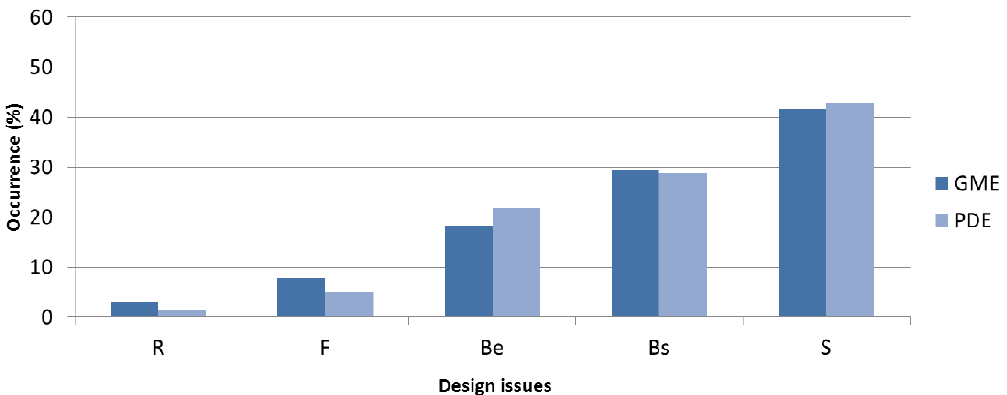
Figure 3. Design issue distribution in GME vs.